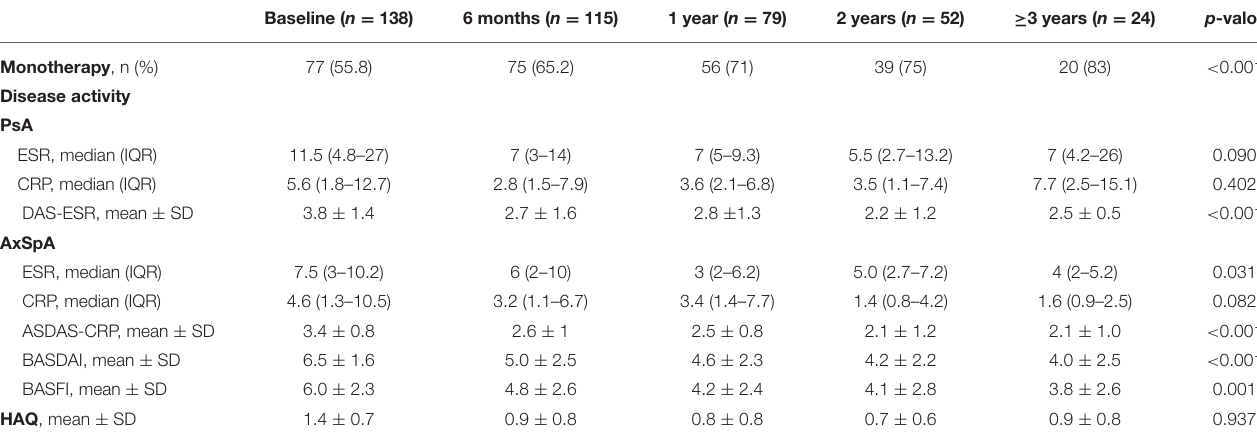
TABLE 2 | Variation of disease activity during treatment with secukinumab.